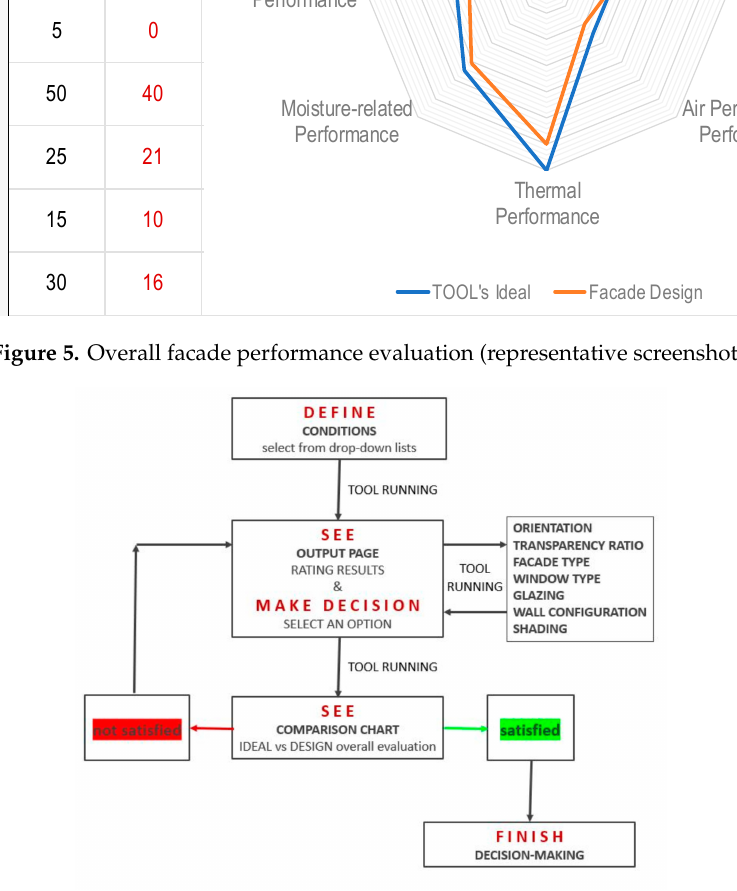
Figure 6. Flowchart for tool